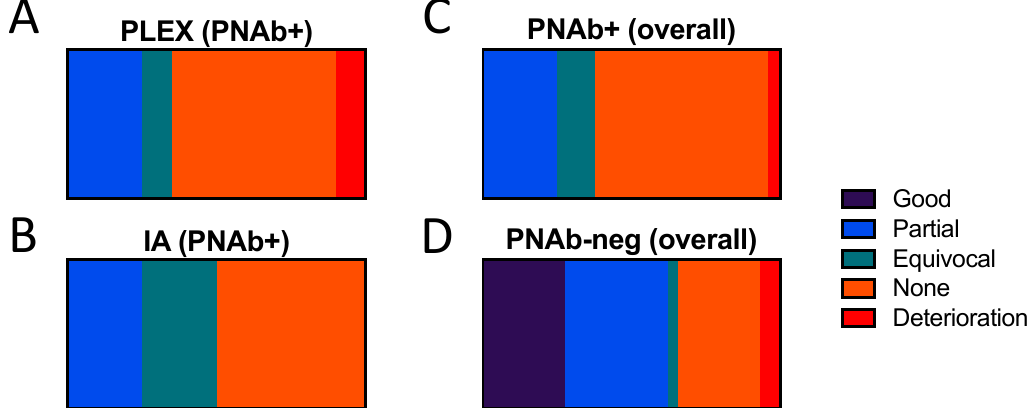
Figure 1. Physician-reported subjective evaluation of response to plasma exchange or immuno- adsorption in paranodal antibody positive and negative patients. Paranodal antibody positive patients treated with ( A ) plasma exchange ( n = 17), ( B ) immunoadsorption ( n = 4), or ( C ) either modality ( n = 21), compared to ( D ) paranodal antibody negative patients ( n = 33) (all treated with plasma exchange). Of the PNAb-negative patients, 33 were treated with PLEx: 8 patients (24.2%) were